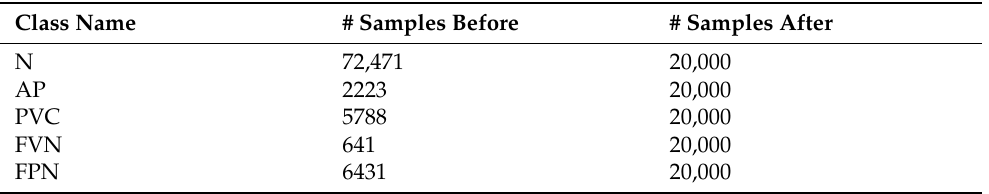
Table 2. Class distributions of MIT-BIH dataset before and after resampling .